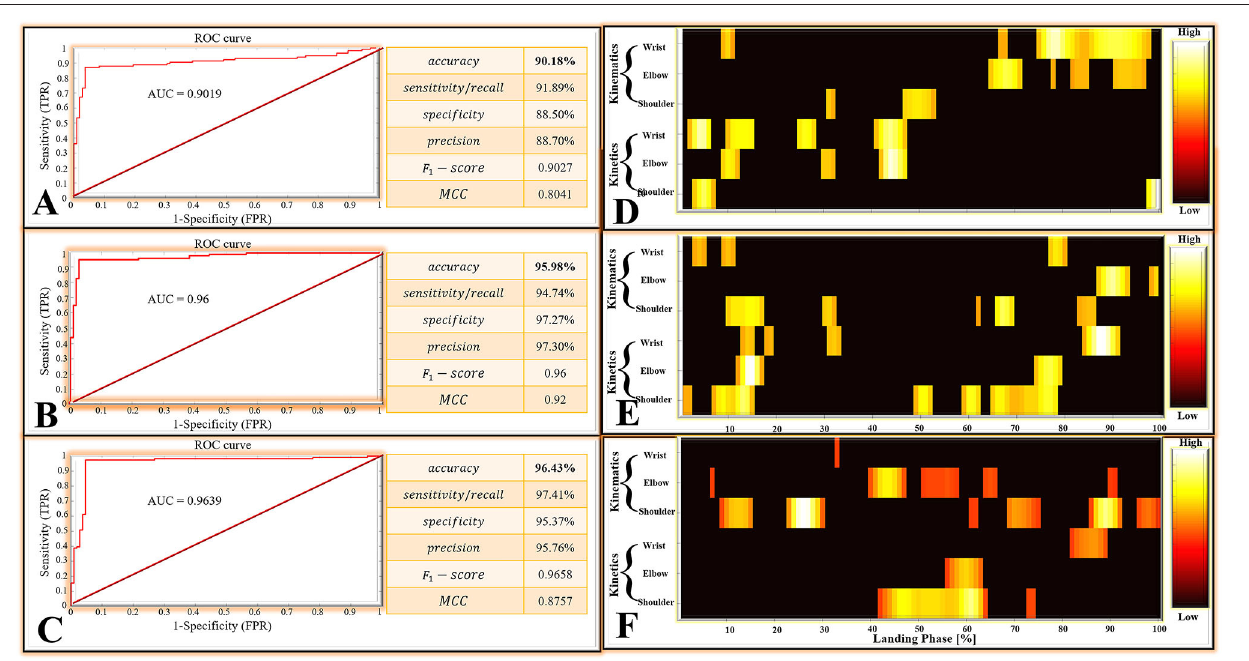
FIGURE 6 | (A) The classifier performance results of the DNN models based on the matrices M 1 . (B) The classifier performance results of the DNN models are based on the matrices M 2 . (C) The classifier performance results of the DNN models are based on the matrices M 3 . ROC, Receiver Operating Characteristic; AUC, Area Under the ROC Curve; MCC, Matthews Correlation Coefficient; TPR, True Positive Rate; FPR, False Positive Rate. (D–F) Notable highly relevant variable during each joint (wrist, elbow, and shoulder) of kinematics (joint angle) and kinetics (joint moment). The top 100 variables with the highest correlation relevance. (D–F) are the result based on matrices M 1 , M 2 , and M 3 ,